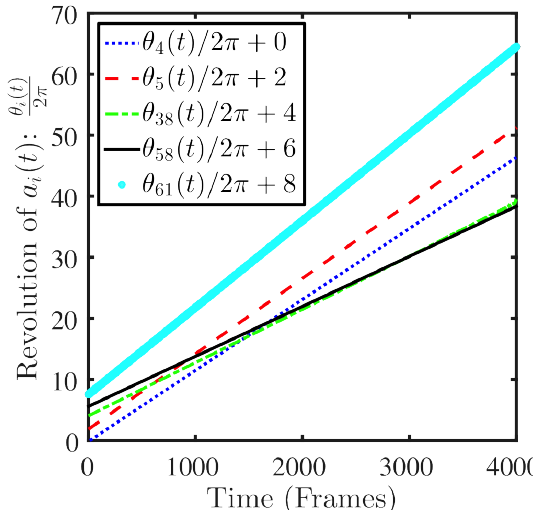
Figure 5. Phase dynamics of robust modes for the reacting flow. “Angular velocities” ω 4 ≈ 0.073 ra- dians/frame and ω 5 ≈ 0.078 radians/frame are nearly identical, suggesting that they belong to the same flow constituent. ( ω 61 is slightly higher and is not used in the reconstruction.) Similarly, ω 38 ≈ 0.055 radian/frame and ω 58 ≈ 0.051 radians/frame are close, suggesting that they form a second constituent. Successive curves are shifted for clarity. This figure was adapted from the Ref.